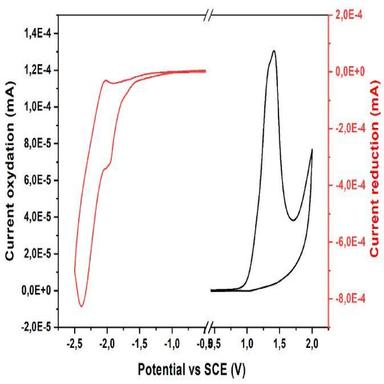
Cyclic voltammograms of thin films of M-DSB coated onto ITO electrode; in 0.1 M (nBu)4NBF4/acetonitrile; scan rate: 50 mV s − 1 .